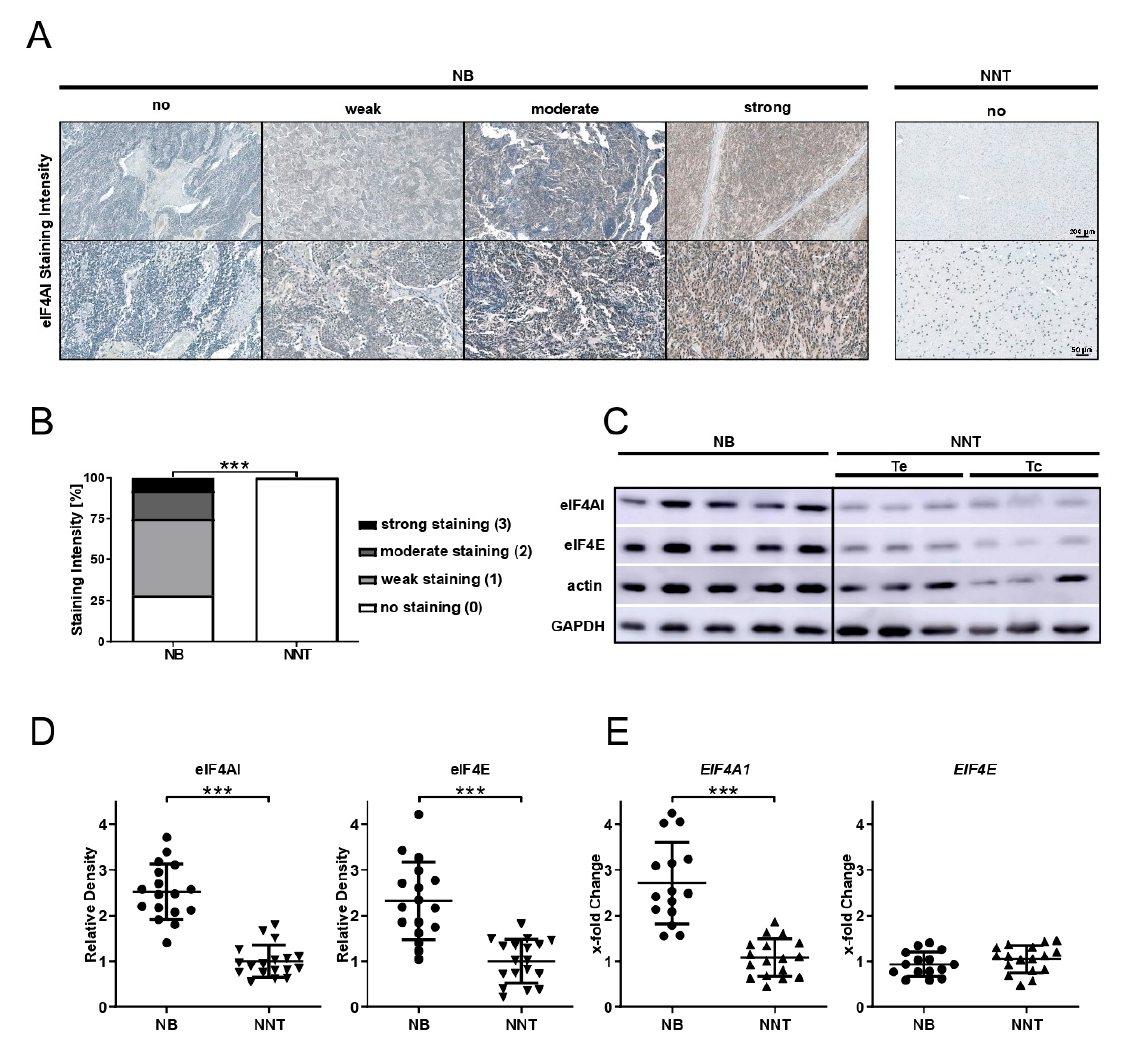
Figure 1. Protein and mRNA expression analysis of eIF4AI and eIF4E in neuroblastic (NB) and non-neoplastic tissue (NNT) reveals the overexpression of eIF4AI in NB compared to NNT. ( A ) Representative immunohistochemical staining with no, weak, moderate, and strong eIF4AI immunoreactivity of NB tissue and no staining of NNT. Scale bars: 200 µ m for upper row and 50 µ m for bottom row. ( B ) Comparison of the immunohistochemical eIF4AI staining intensity of NB (n = 36) and NNT (n = 18) using the Mann–Whitney U test. *** p < 0.001; no staining (white bar) NB n = 10, NNT n = 18; weak staining (light grey bar) NB n = 17; moderate staining (dark grey bar) NB n = 6; strong staining (black bar) NB n = 3. ( C ) Representative immunoblots for eIF4AI, eIF4E, actin, and GAPDH expression in NB and NNT. Te, temporal cortical brain tissue; Tc, thoracic spinal cord tissue. ( D ) Relative density values of eIF4AI and eIF4E expression of each sample [NB (n = 17) and NNT (n = 18)] determined by immunoblotting normalized to average of loading control (actin and GAPDH). Densitometrical analysis was performed using ImageJ. Unpaired t -test was used for statistical analysis, bars represent mean ± SEM, *** p < 0.001. ( E ) Gene expression analysis (qRT-PCR) of EIF4A1 and EIF4E in NB (n = 17) compared to NNT (n = 18). Data are shown as x-fold change using the 2 - ΔΔ Ct method. Mean of IPO8 and SDHA served as endogenous controls. Unpaired t-test was used for statistical analysis, bars represent mean ± SEM, *** p < 0.001.